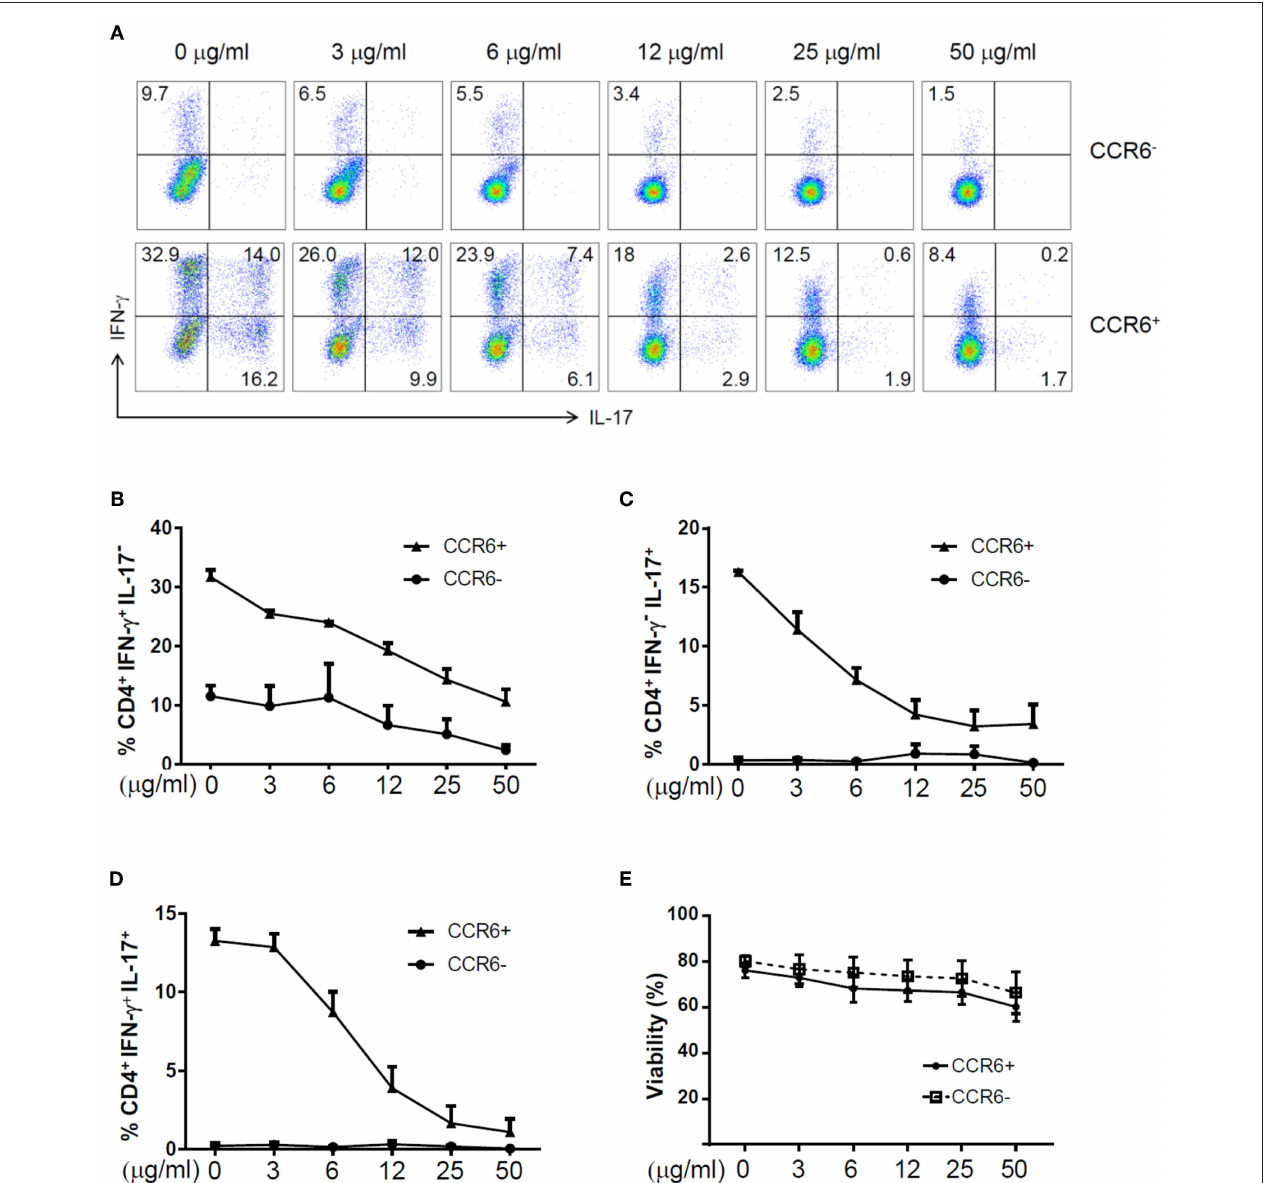
FIGURE 1 | The expression of IFN- γ and IL-17A in zebularine-treated human CD4 + T cells in vitro . (A) Representative dot plots ( N = 4; 3 female and 1 male; average age of 42) for stimulated human CD4 + CCR6 − and CD4 + CCR6 + cells on Day 5, stained with IFN- γ and IL-17A. The frequency of CD4 + IFN- γ + IL-17 − (B) , CD4 + IFN- γ − IL-17 + (C) , and CD4 + IFN- γ + IL-17 + (D) Cells in zebularine-treated human CD4 + CCR6 + and CD4 + CCR6 − cells. (E) Viability of CD4 + CCR6 − and CD4 + CCR6 + cells treated with different doses of zebularine. Means ± SD are shown.